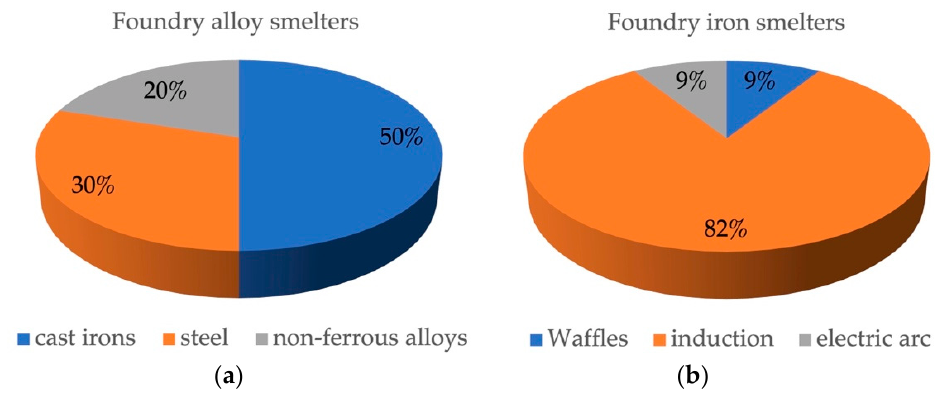
Figure 1. Structure of lost foundry alloys: ( a )—foundry alloy smelters, ( b )—foundry iron smelters.